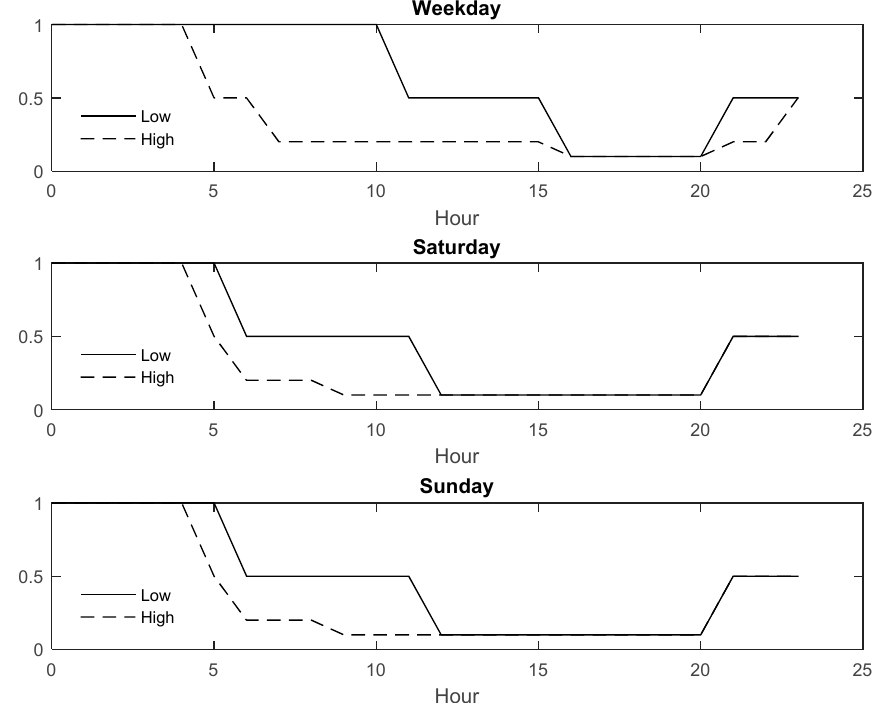
Figure 15. Lambda value for external demand scenario.